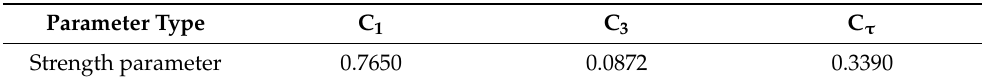
Table 8. Strength parameters of uniaxial penetration.